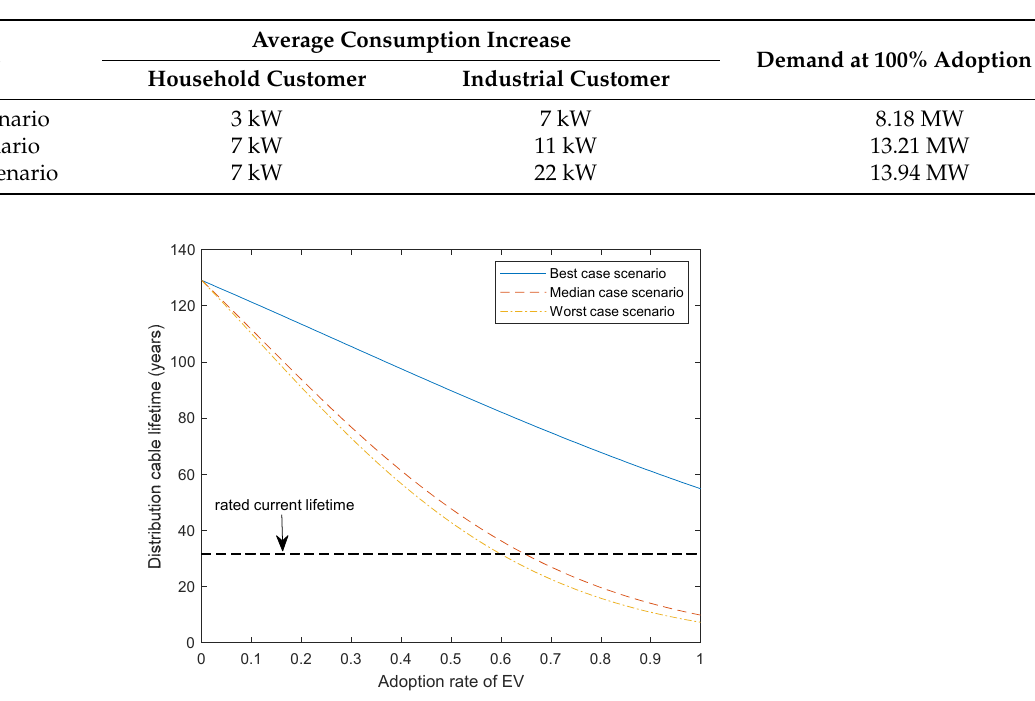
Table 4. Three different scenarios for EV consumption at 11 kV.